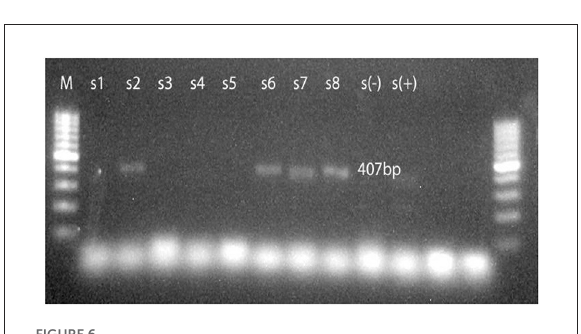
FIGURE6 Tomato in tomato seeds mosaic view of the RT-PCR test result for tobamovirus taken on the gel imaging system.